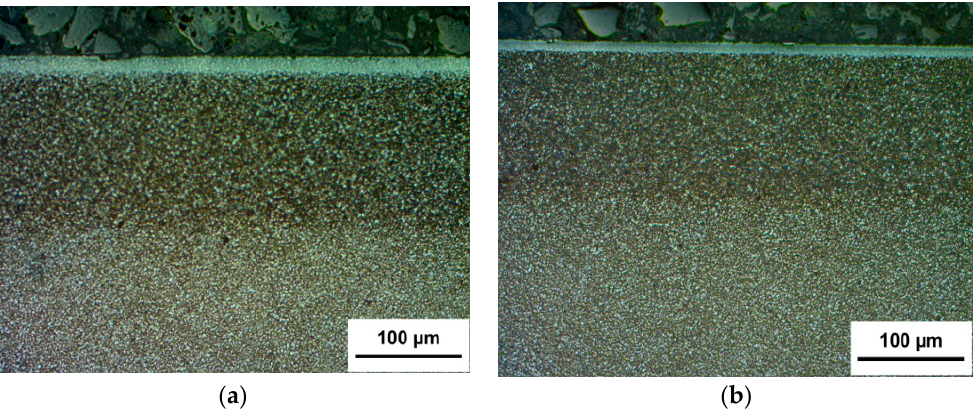
Figure 4. Optical photographs of a cross-section of SL of Vancron 40 steel after: ( a ) Grinding– sulphonitriding (G-SN); ( b ) hard turning–slide burnishing with 130 N force–sulphonitriding (T-B130-SN).